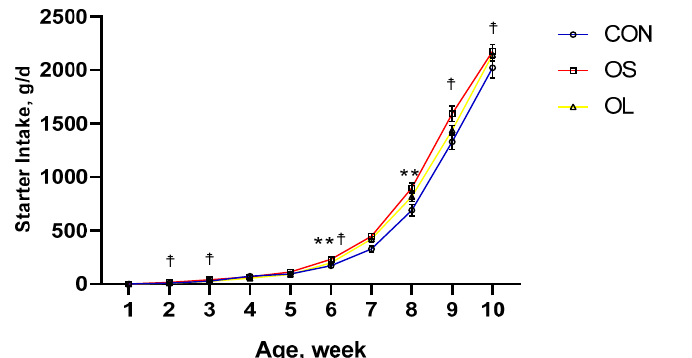
Figure 3. Calf starter intake for Holstein female calves fed a basic diet without hay (CON: empty circles; red line) and inclusion of short oat hay (OS: 3–5 cm, empty squares; green line) or inclusion of long oat hay (OL: 10–12 cm, empty triangles; blue line). Differences between CON with hay are represented by an asterisk ( p < 0.05, denoted by **). Differences between OS with OL are represented by a cross ( p < 0.05, denoted by ☨ ).